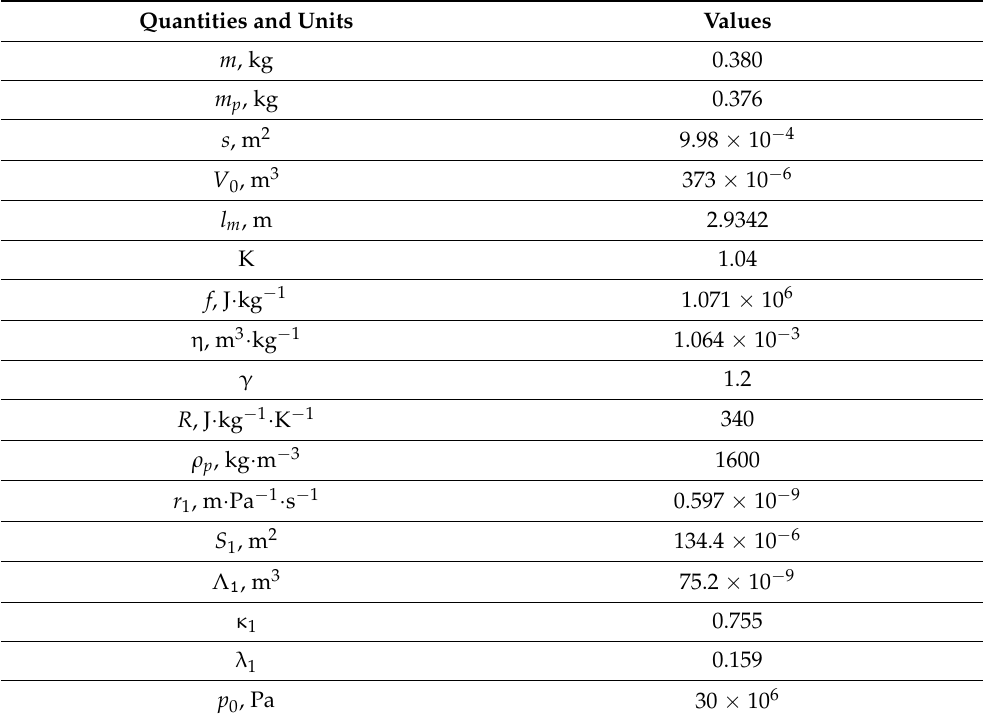
Table 1. Input data to interior ballistics calculation. Quantities and Units Values m , kg 0.380 m p , kg 0.376 s , m 2 9.98 × 10 −